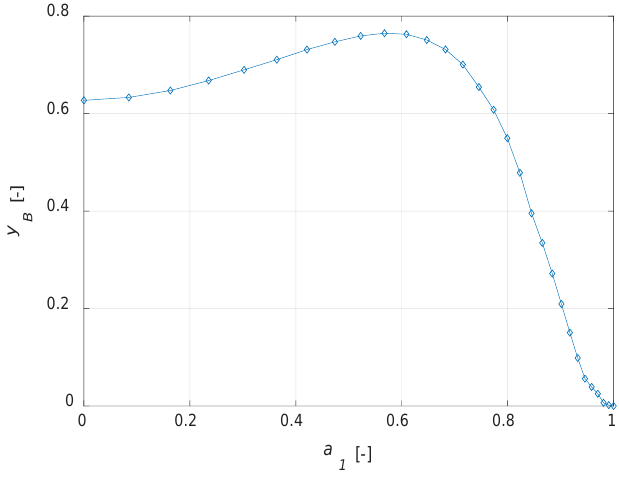
Figure 5. Yield to B ( y B ) vs. active phase inert fraction coordinate ( a 1 ) for the egg-shell catalyst.